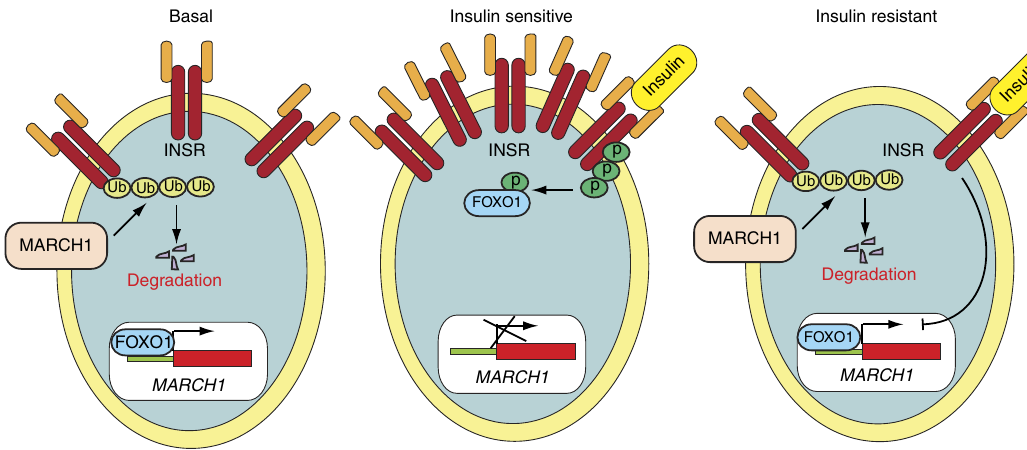
Figure 10 | Model for MARCH1-mediated regulation of insulin action. In the basal state, MARCH1 ubiquitinates and degrades INSR b ; thereby reducing surface INSR expression. In the insulin-sensitive state, INSR activation inhibits FOXO1, resulting in transcriptional repression of MARCH1 , increased surface INSR levels, and preserved insulin signalling. In the insulin-resistant state, insulin fails to inhibit FOXO1, resulting in inappropriately increased MARCH1 expression, decreased surface INSR levels, and impaired insulin